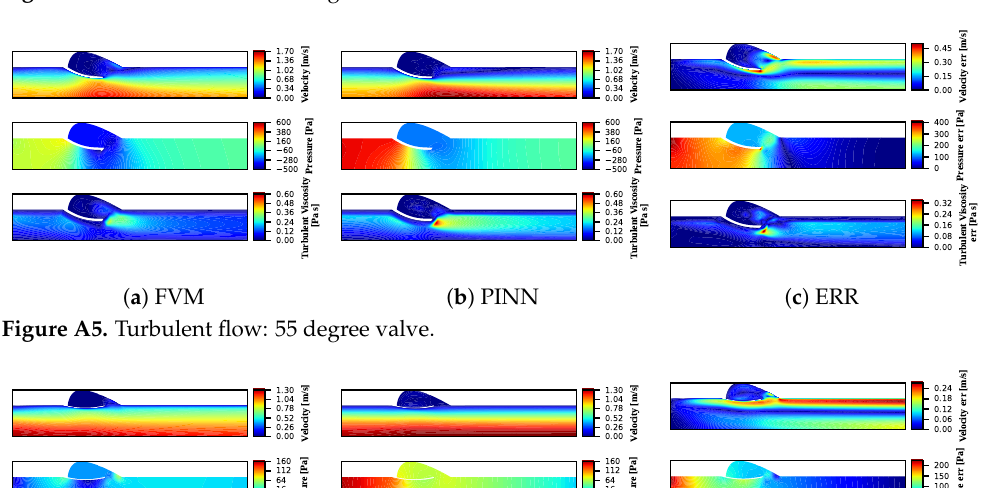
Figure A4. Turbulent flow: 35 degree valve.